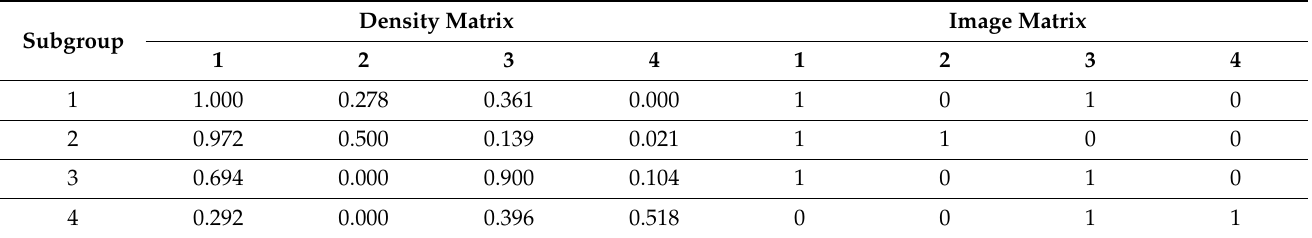
Table 2. Density matrix and image matrix of four subgroups in 2018. Density Matrix Image Subgroup